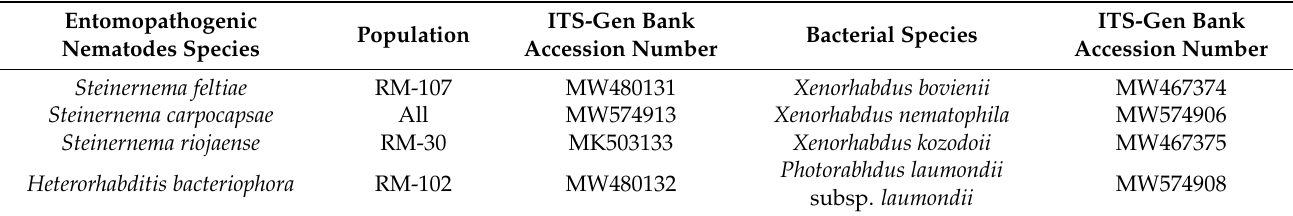
Table 2. Steinernema and Heterorhabditis species and their symbiotic bacteria species ( Xenorhaddus and Photorhabdus ) tested for their effects as biocontrol agent against Lobesia botrana